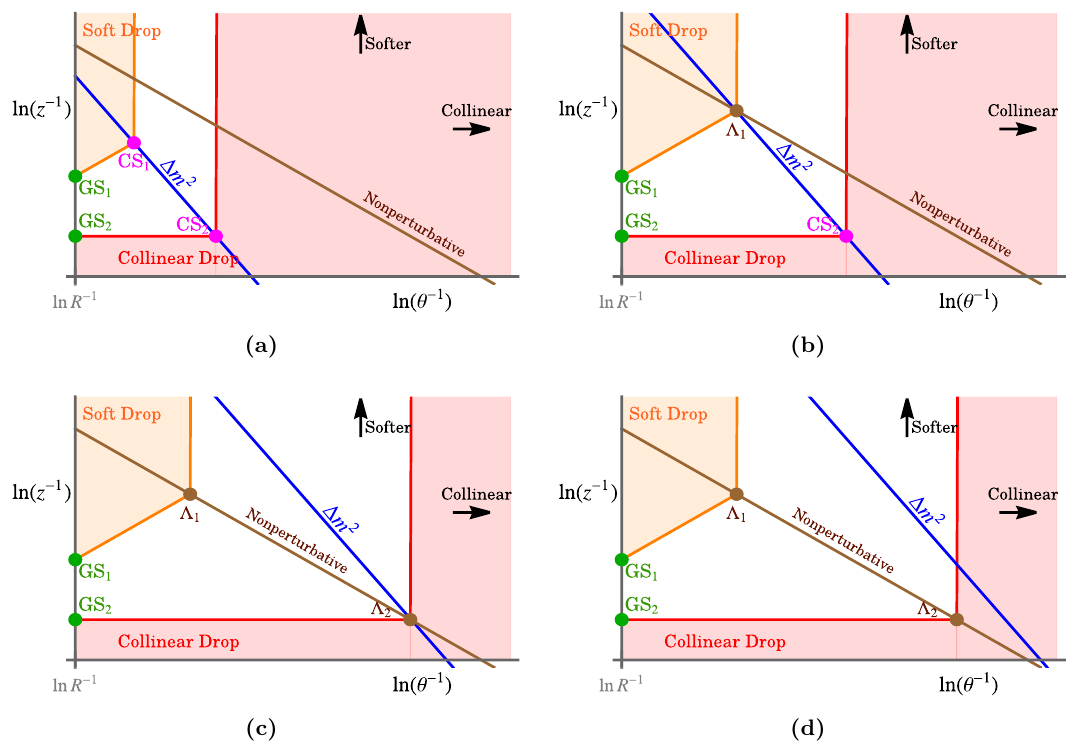
Figure 1. Relevant modes of the factorization formula of jet mass in collinear drop in the (ln( θ − 1 ) , ln( z − 1 )) plane. The orange and red shaded areas indicate phase space regions removed by the collinear drop procedure. The solid brown line indicates the onset of nonperturbative con- tributions. The solid blue line represents the measurement of the collinear drop squared jet mass ∆ m 2 . The value of ∆ m 2 decreases as we go from panel a) to d). In panel a) it is in a perturbative regime, in panel b) the CS 1 mode transitions to being nonpertubative, in panel c) the CS 2 mode transitions to being nonperturbative, and in panel d) we are deep in the nonperturbative